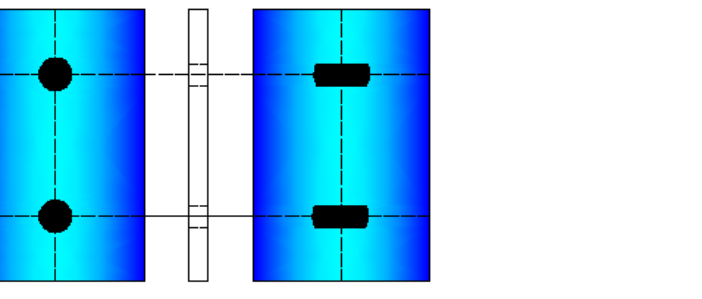
Figure 9. Fixed and expansion elastomeric bearing types, depending on the dimensions of the slot.